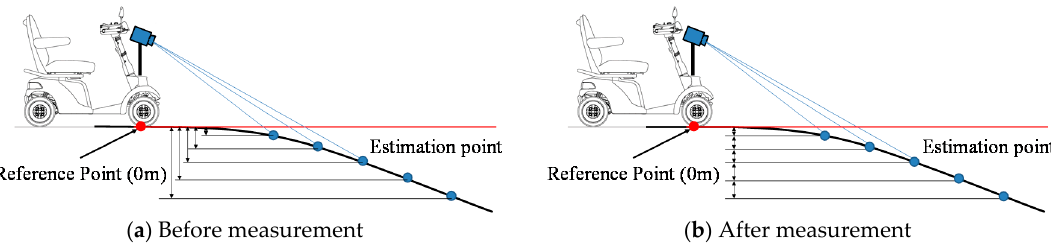
Figure 5. Measures against error caused by a change of road gradient conversion.